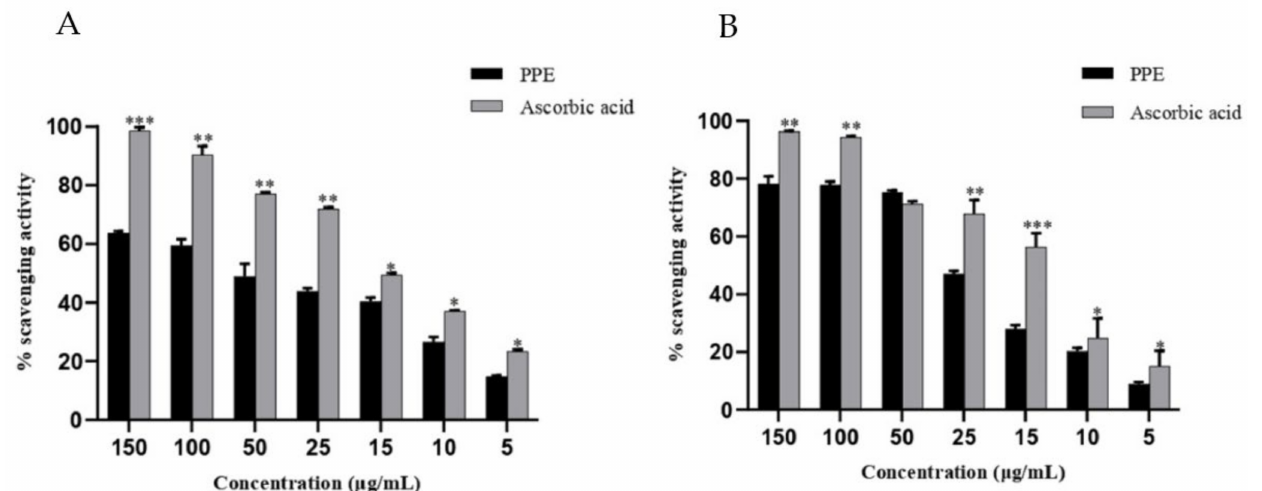
Figure 1. Anti-radical activity of PPE and standard ascorbic acid in various concentrations 5–150 µ g/mL as determined by using ( A ) DPPH and ( B ) ABTS.The values indicate ± SD ( n = 3); * p < 0.05, ** p < 0.01, and *** p < 0.001 vs. PPE. Table 1. IC 50 values of ascorbic acid and PPE for their anti-oxidant activity. Anti-Radical Assay